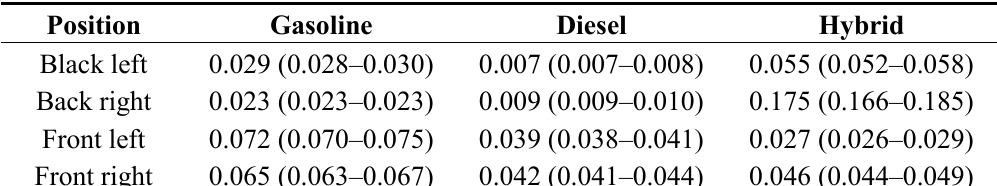
Table 4. Geometric Mean (95% CI) magnetic field (μT) by seat position and engine type; adjusted for car model and operating condition.